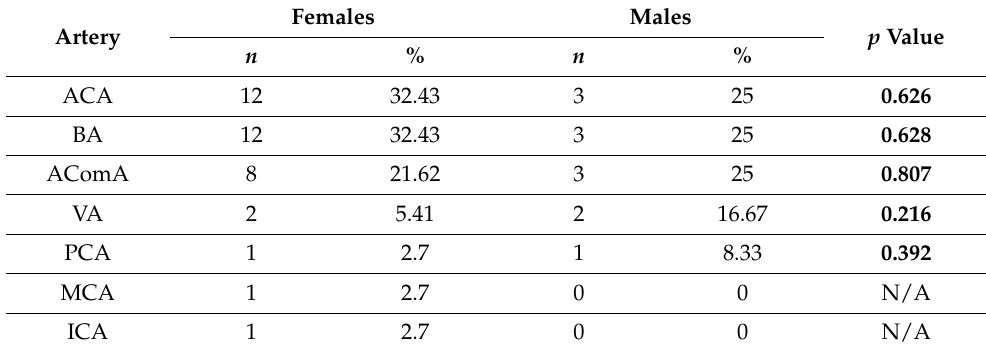
Table 5. Gender of patients by type of vascular fenestration.